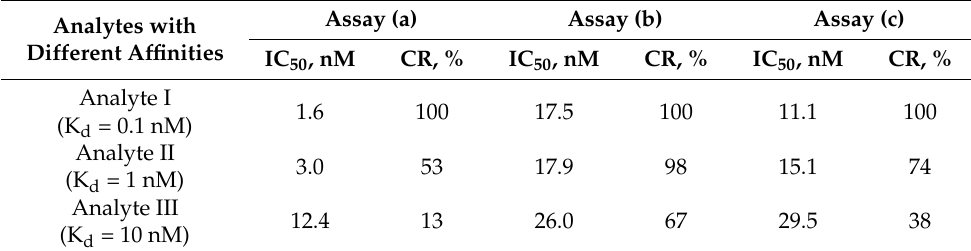
Table 1. IC 50 values (nM) for the calibration dependences given in Figure 3. Analytes with dif ‐